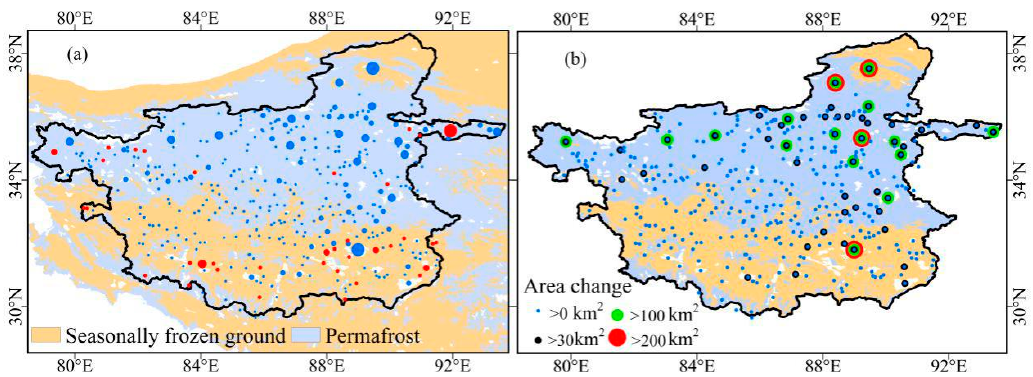
Figure 4. ( a ) The spatial patterns of lake change and permafrost types over the endorheic basin (the blue dots mean lake expansion and red dots mean lake shrinkage); and ( b ) the spatial difference of lake expansion in continuous permafrost over the endorheic basin. The permafrost distribution was provided by Zou et al. [1]. The black line contour is the QTP endorheic basin.